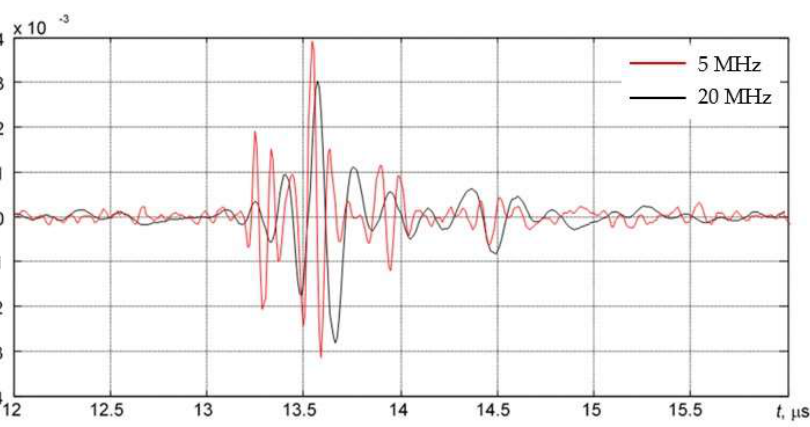
Figure 8. The waveforms of the received signals at the point AUBT-1 with 5 MHz (black) and 20 MHz (red) transducers.